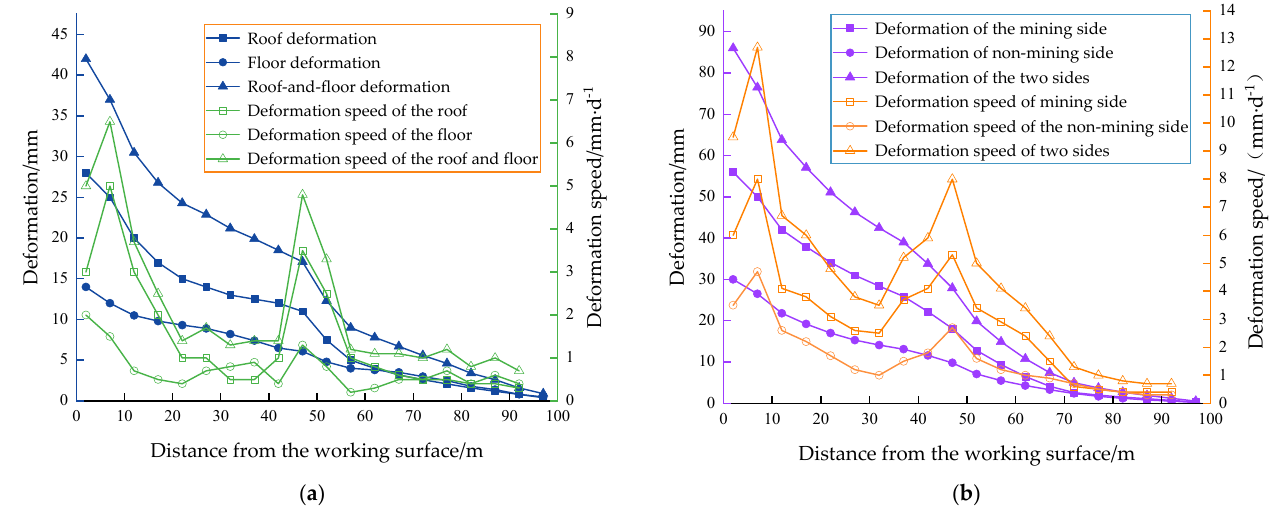
Figure 20. Side support of return-air roadway in working face 3204.